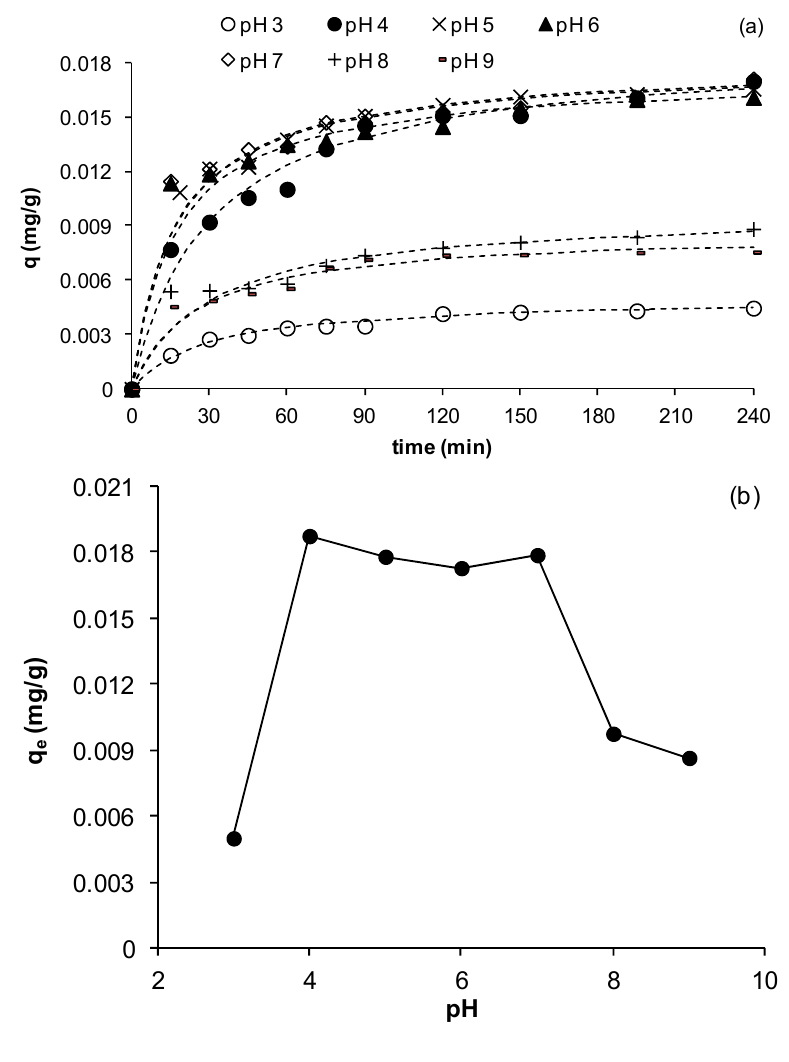
Figure 5. Effect of initial pH on the adsorption of Cu ions by MCS ( a ) change of q as function of time at different pHs; ( b ) effect of pH on equilibrium adsorption uptake, q ( γ = 0.0709 mg Mn/g sand, m Mn speed = 150 rpm, T = 25.6